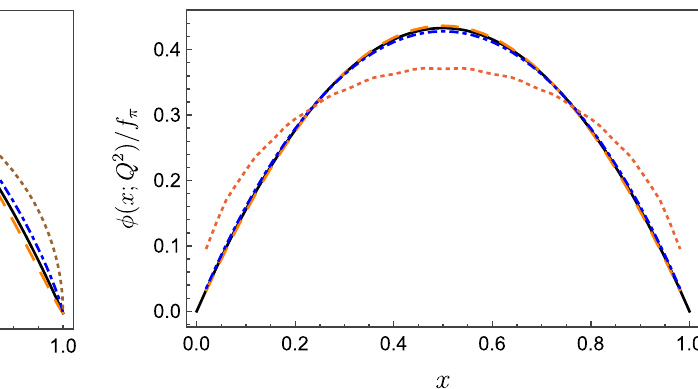
GSW and SW [73] models, see Eq. (51). Left panel: calculations of the DA in the asymptotic limit without evolution. Right panel the same as the left panel but including the ERBL evolution for Q 2 = 1 . 5 GeV 2